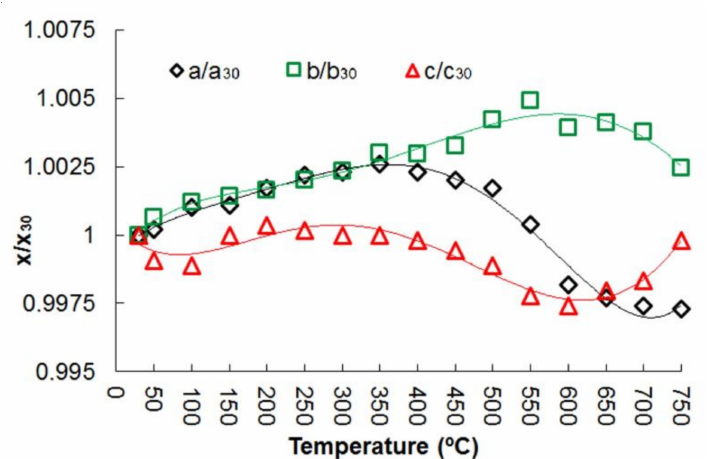
Figure 5. Normalized unit cell parameters of potassic-hastingsite vs temperature. Symbols: a / a 30 — black diamonds; b / b 30 —green squares; c / c 30 —red triangles. Estimated standard deviations are smaller than the symbol used. A fifth-order polynomial approximation has been used for trend lines.